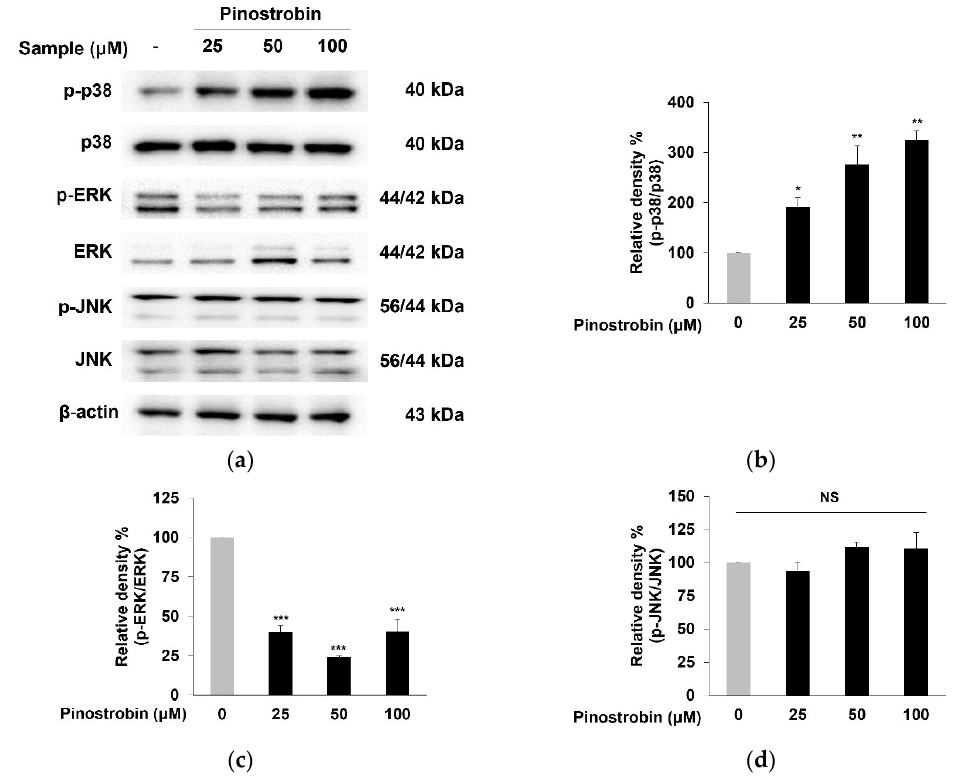
Figure 5. Effect of pinostrobin on the phosphorylation of p38, ERK, and JNK in B16F10 cells. ( a − d ) Cells were treated with pinostrobin at various concentrations for 24 h and then harvested. p − p38, p − ERK, and p − JNK, were analyzed by Western blotting. Blots were quantified using ImageJ software. Protein levels were normalized to the corresponding loading controls. The untreated cells were regarded as 100%. Values are expressed represent as the mean ± SD of three independent experiments. *** p < 0.001 ** p < 0.01, and * p < 0.05 compared with control group. NS; not significant.